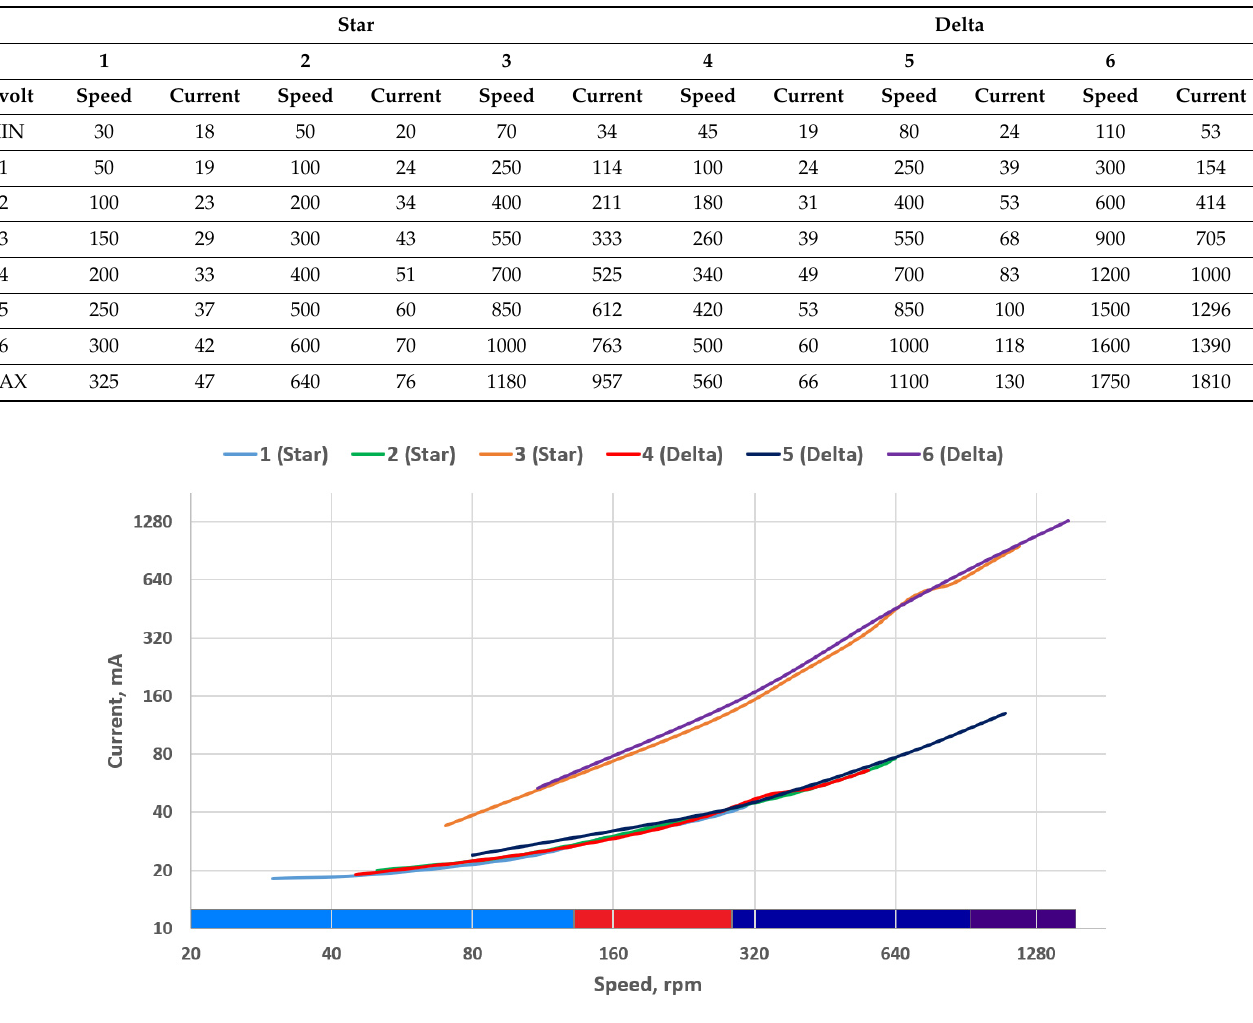
Figure 11. Dependency of RPM on the connection of the stator windings and operating current .